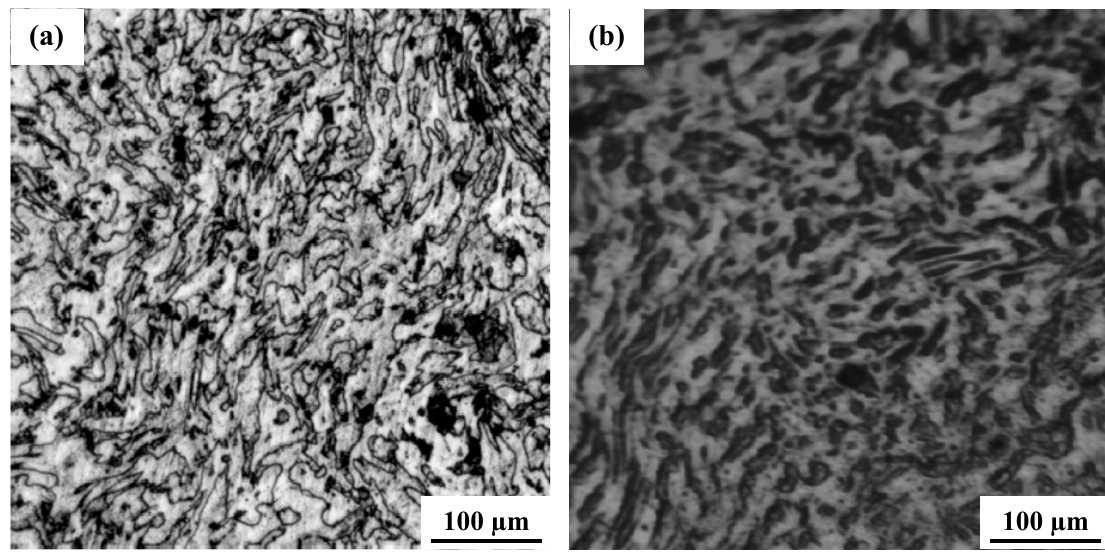
Figure 1. Optical micrographs showing the undeformed microstructure of : ( a ) alloy AZ31 and ( b ) alloy AZ31 reinforced with nano Al powder